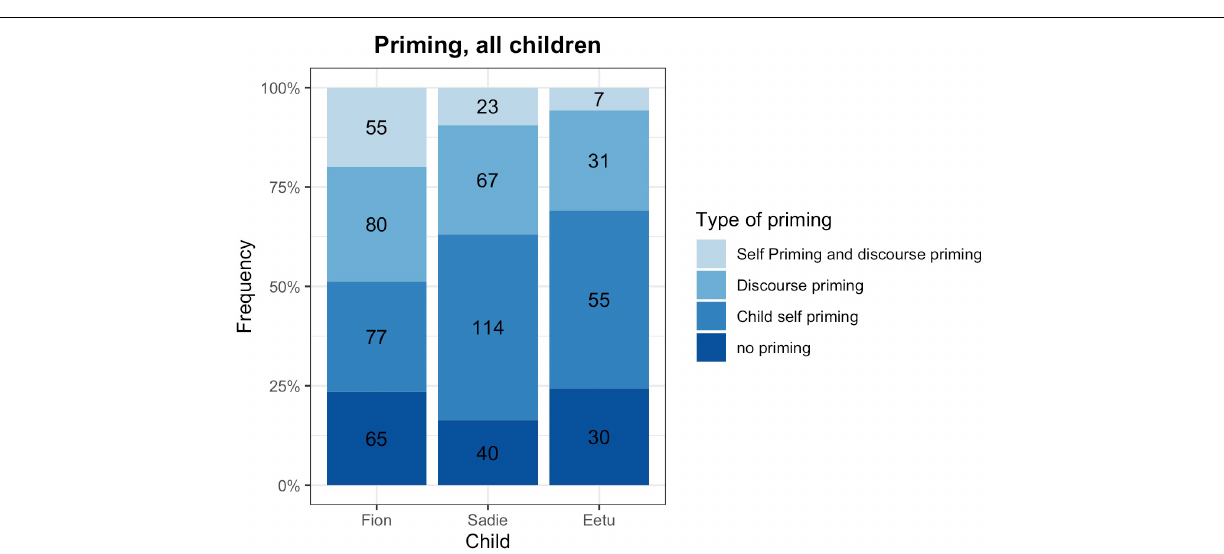
FIGURE 3 | Type of priming. Numbers in the bars indicate the number of